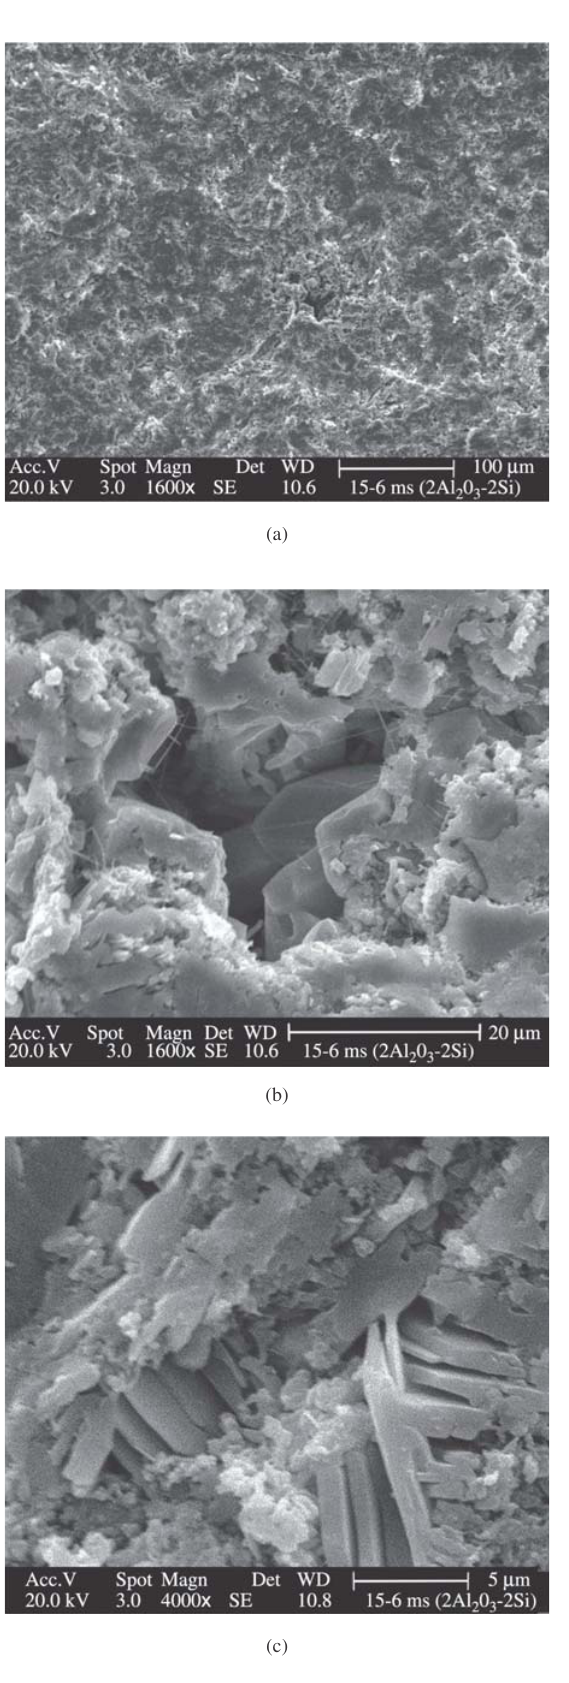
Figure 7. SEM micrographs of the fracture surface of the sample pyrolysed at 1500 °C/2 h: a) general image; b) and c) details inside the pores.